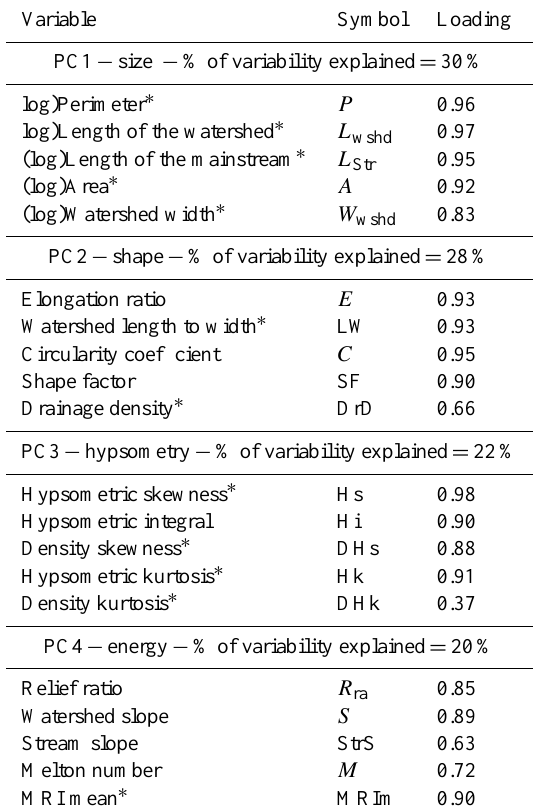
Table 2. Principal components and corresponding variables. The symbol column shows the abbreviation used in the formulas, and the loading column corresponds to the correlation of each variable with the corresponding principal component. Variables belonging to the PC1 were log-transformed, and variables with the symbol ∗ were transformed as 1 − (value − minimum input value)/(maximum input value − minimum input